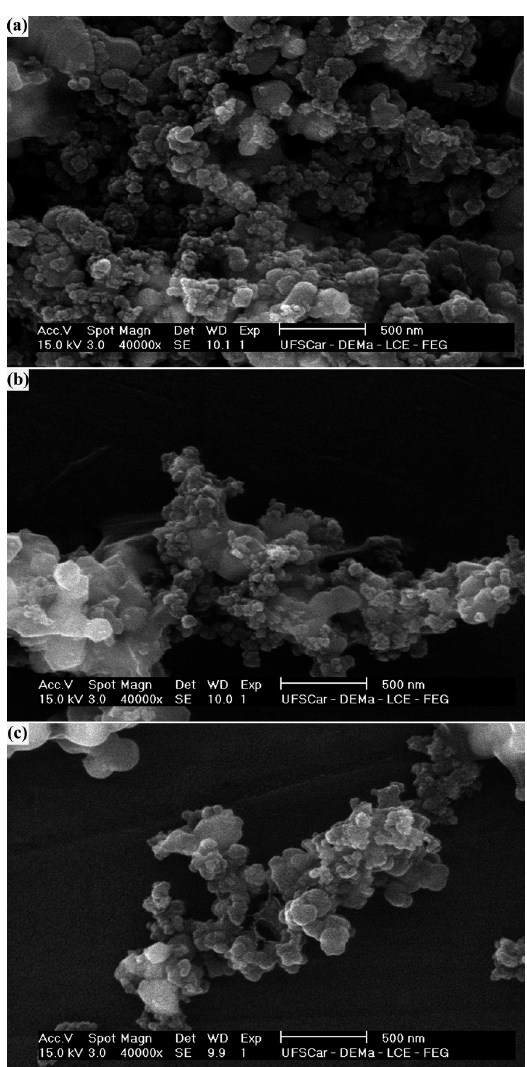
to coalesce in response to surface charges, as reported by other researchers 15 . Increasing the reaction time caused the mean particle size to increase, resulting in the formation of some melt inclusions due to the high temperatures reached during the reaction, even at 3 kW. The particle sizes are depicted in Figure 2. The nanometric particle sizes of the ZrC-SiC powders synthesized by this method (in the aforementioned conditions) were smaller than those obtained by other researchers 7 using a similar method, corresponding to ZrC-SiC particle sizes at the micron scale. These results confirm that carbothermal reduction is advantageous to synthesize ZrC-SiC powders. The use of microwave power as a heating source proved to be efficient in synthesizing well crystallized ZrC-SiC nanopowders, and the reaction remained close to the planned